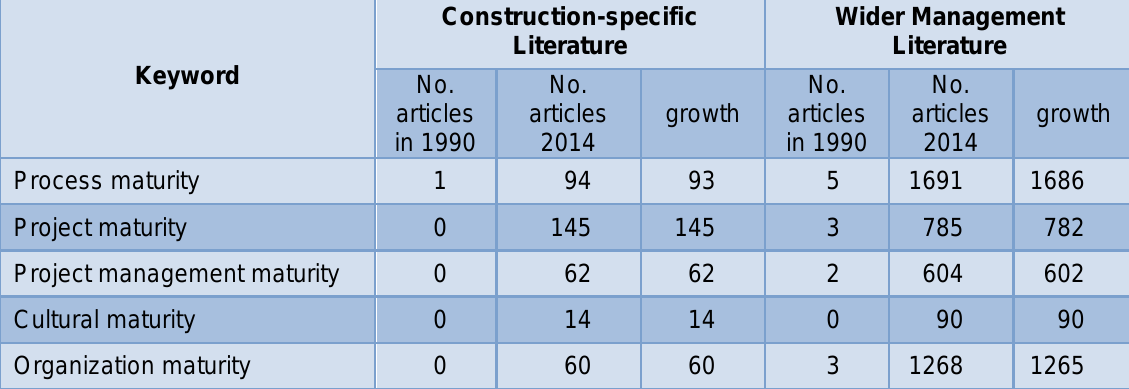
Table1 Growth in the context of construction-specific literature and the wider management